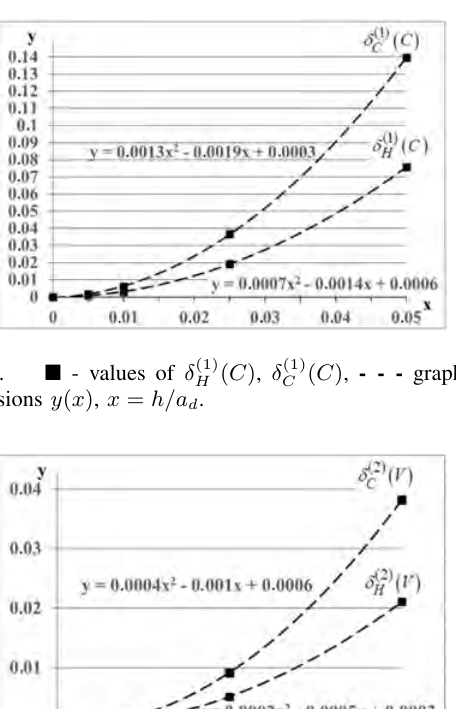
Fig. 7. (cid:4) - values of δ (1) regressions y ( x ) , x = h/a d .